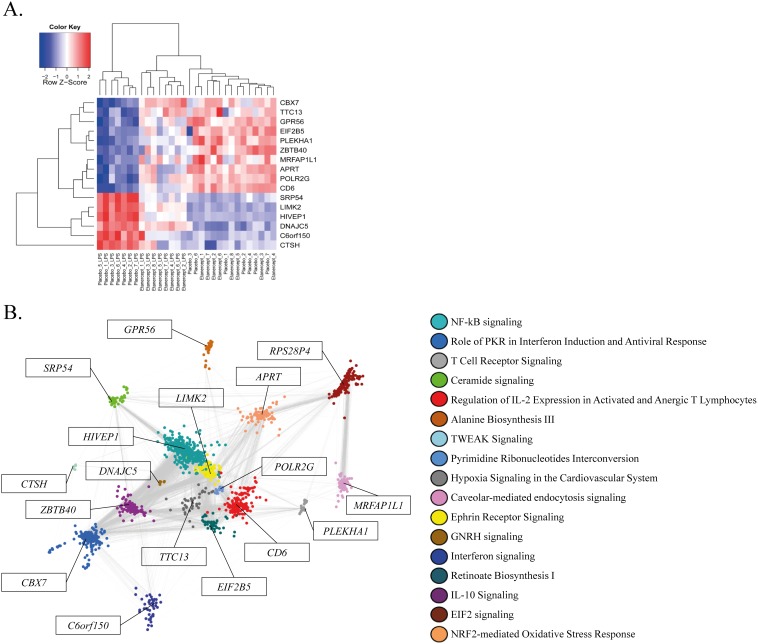
TNFα responsive module hub (driver) genes and co-expression network visualization.Genes within transcriptional modules can be categorized as peripheral or hubs on the basis of how correlated a gene is with all other genes in the network, defined as the genes' connectivity measure, k. High intramodulr connectivities denote highly important module genes oftentimes possessing transcriptional factor activity. A. Unsupervised hierarchical clustering heatmap plot of the TNFα responsive module hub genes. Red denotes high expression; blue denotes low expression. The relative importance of each module within the co-expression network can be highlighted by unsupervised visualizations of each genes' weighted correlation coefficient. This was implemented in the Cytoscape® platform B. TNFα responsive co-expression modules were visualized by an organic layout considering weighted correlation coefficients >0.1 (equivalent to correlation coefficient >0.9).